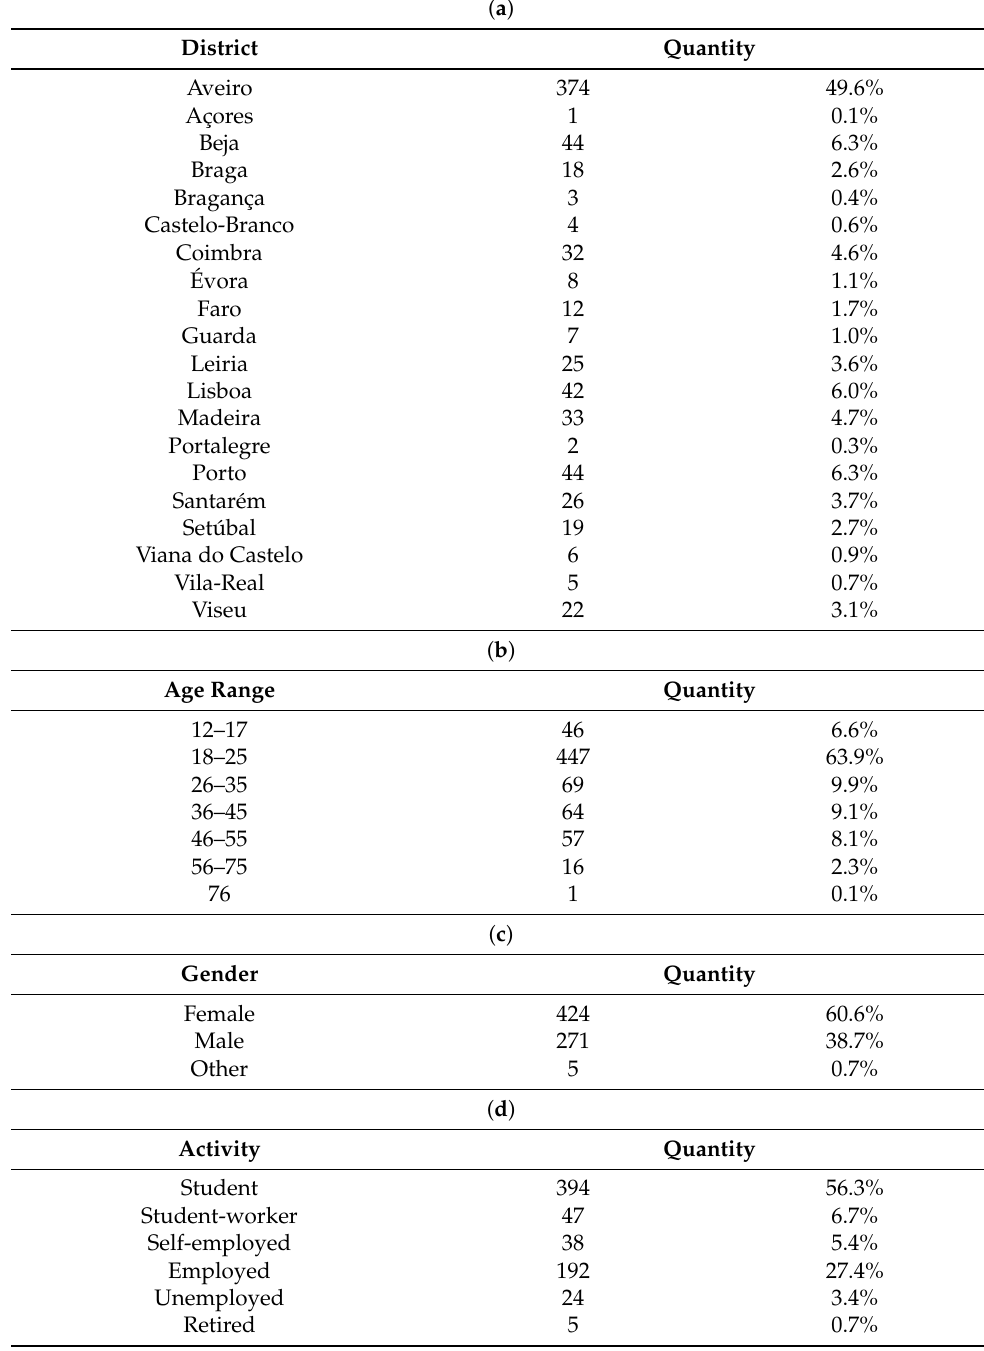
Table 1. Characterization of the sample considering the ( a ) gender, ( b ) age range, ( c ) activity, and ( d ) district of residence of the